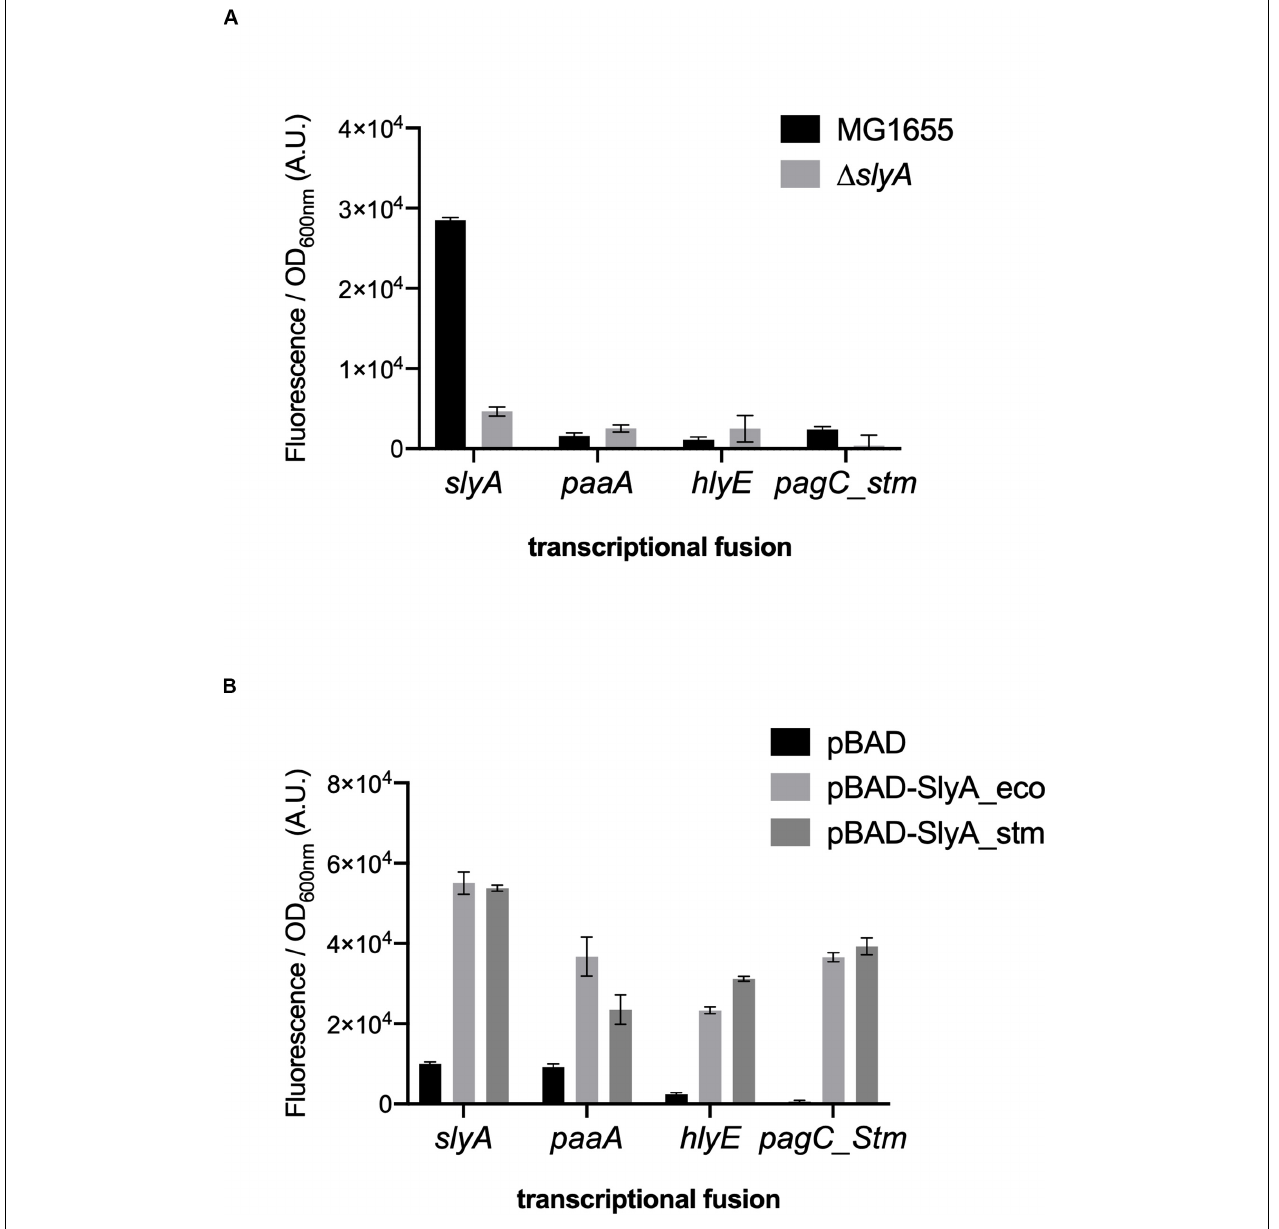
FIGURE 1 | slyA , paaA , hlyE , and pagC _stm promoters are induced by SlyA. (A) Comparison of transcriptional fusion activity in wild type MG1655 and in the slyA mutant EB1073 strains grown overnight at 30 ◦ C in LB. (B) Transcriptional fusion activity when SlyA protein is overproduced. MG1655 strains transformed by the indicated transcriptional fusions and the pBAD24 (pEB227), pBAD-slyA_ecoli (pEB1609), or pBAD_slyA_stm (pEB1610) plasmids were incubated overnight at 30 ◦ C in LB supplemented with 0.05% arabinose. The activities correspond to the ratio between GFP fluorescence and OD 600 nm of 6 replicates, given in arbitrary units (A.U.). The error bars show the